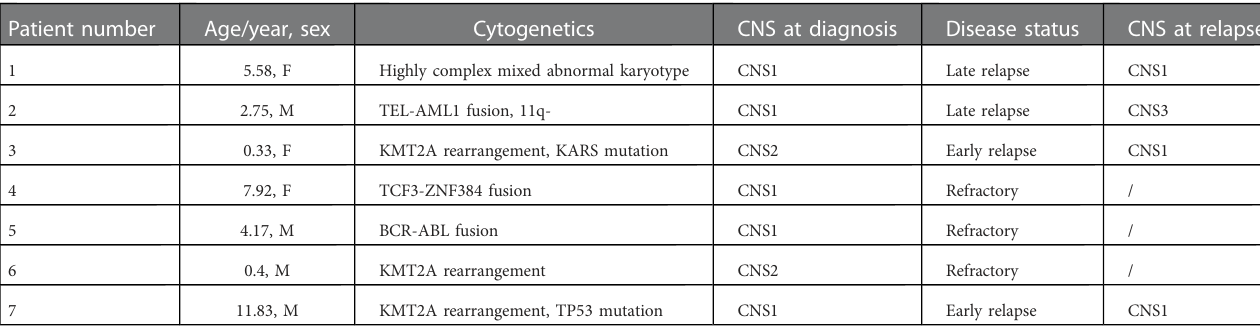
TABLE 1 Clinical characteristics of seven patients at